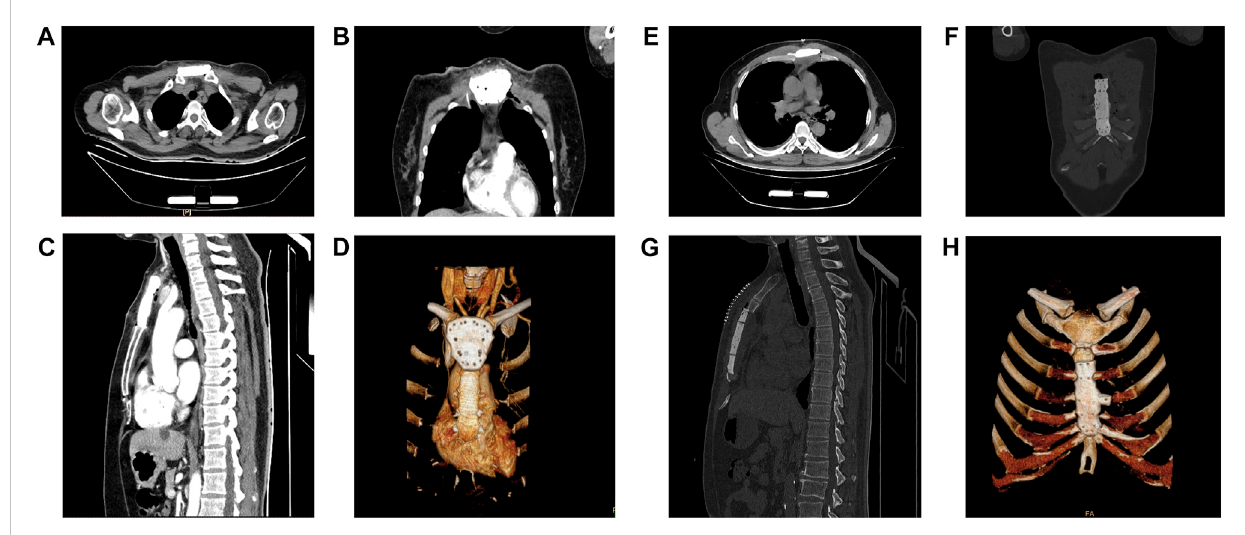
FIGURE 3 Postoperative computerized tomography (CT) images of the patients. (A,E) The CT images of sternal prosthesis in the transverse view. (B,F) The CT images of sternal prosthesis in the coronal view. (C,G) The CT images of sternal prosthesis in the sagittal view. (D,H) The 3D reconstruction of the sternal prosthesis on CT is